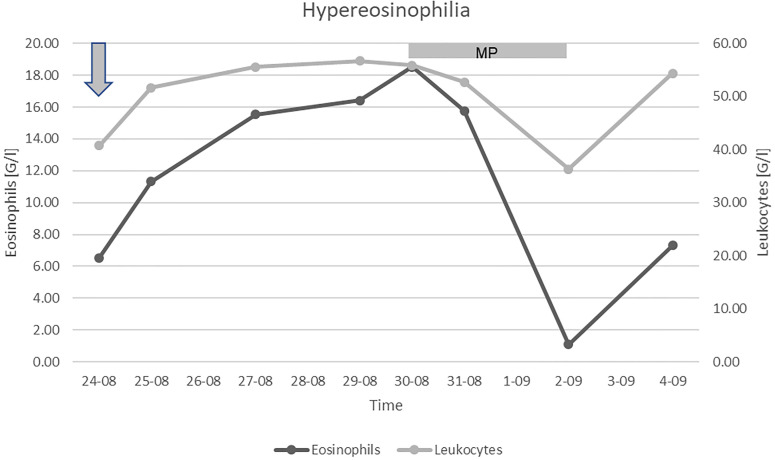
Leukocyte and eosinophilic granulocyte count. Arrow: admission to our Clinic, MP: treatment with methylprednisolone.